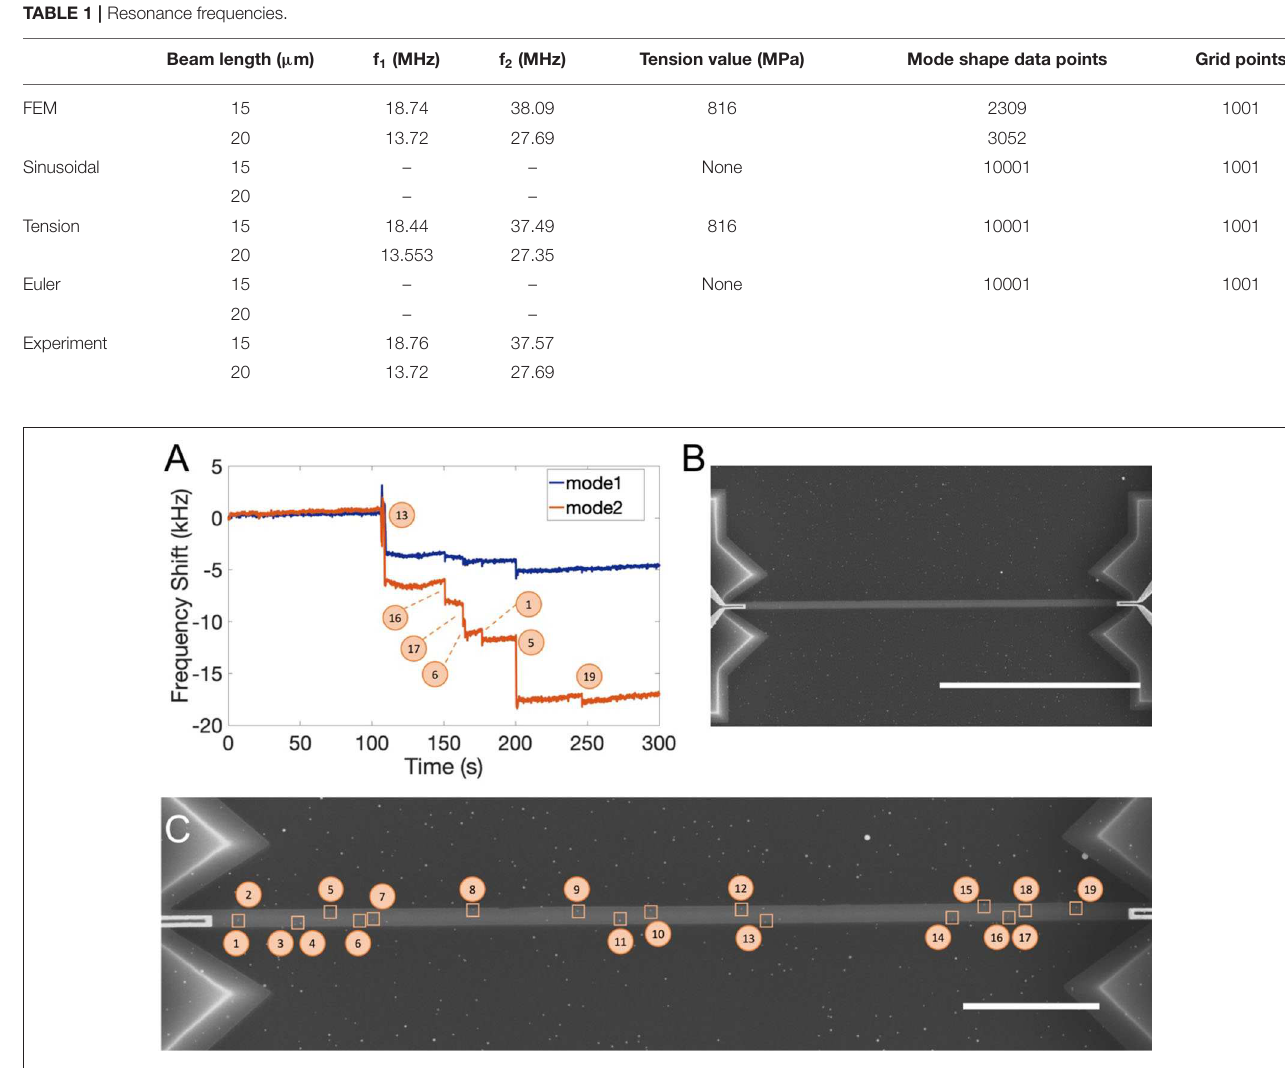
FIGURE 2 | GNP adsorption events tracked by PLL. (A) Each frequency shift represents an individual event. PLL has ∼ 500ms time constant. The numbers indicate the particles that are later identified under SEM in part C. (B) SEM image of NEMS resonator after nanoparticle adsorption. The scale bar is 10 µ m. (C) Collage of three high-resolution SEM images for recording the positions of the nanoparticles. Particles with ambiguous matching between the NEMS and SEM measurements were excluded from the analysis to reduce uncertainty. The scale bar is 3 µ m.